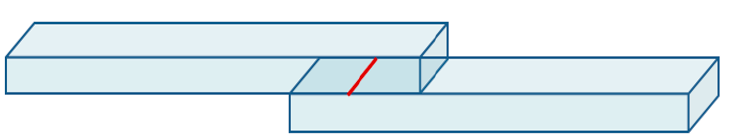
Figure A1. The two bars in contact before deformation. The red line indicates the path at the center of the contact area, along which the mechanical fields were extracted.